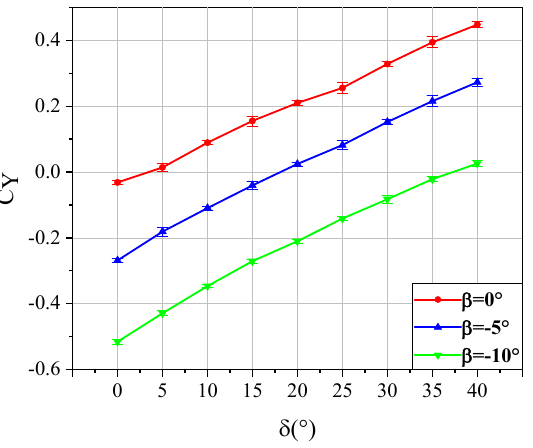
Figure 7. Lateral force coefficient of vertical tail model under different sideslip angles ( Re = 2.12 × 10 5 ). The reasons for the change of the lateral force coefficient are explored through the study of rudder surface pressure. Under the condition of β = 0° and Re = 2.12 × 10 5 , the pressure coefficient curve of the rudder surface at different rudder deflection angles is shown in Figure 8. It can be seen from the figure that when the rudder deflection angle is less than 15°, the surface pressure coefficient curve presents a significant “negative slope”, and the negative pressure gradually decreases along the flow direction. There is a pres ‐ sure gradient due to the attached flow on the rudder. With the rudder deflection angle increase, the overall pressure coefficient curves “move up”. The negative pressure at the rudder trailing edge increases. However, when the rudder deflection angle is increased to 20°, especially after 25°, the slope of the pressure coefficient curve is entirely different from that when the rudder deflection angle is slight, showing a slope close to “0”. Flow separa ‐ tion occurs on the rudder, and the pressure taps are all in the flow separation zone. The change of the pressure data curve corresponds to the gradual slope of the lateral force coefficient curve above. ( a ) ( b ) Figure 8. Rudder pressure distribution at different deflection angles: ( a ) δ = 0°~15°; ( b ) δ = 20°~40° ( β = 0°, Re = 2.12 × 10 5 ). Under the condition of β = − 10° and Re = 2.12 × 10 5 , the pressure coefficient curve of the rudder surface at different rudder deflection angles is shown in Figure 9. Since the